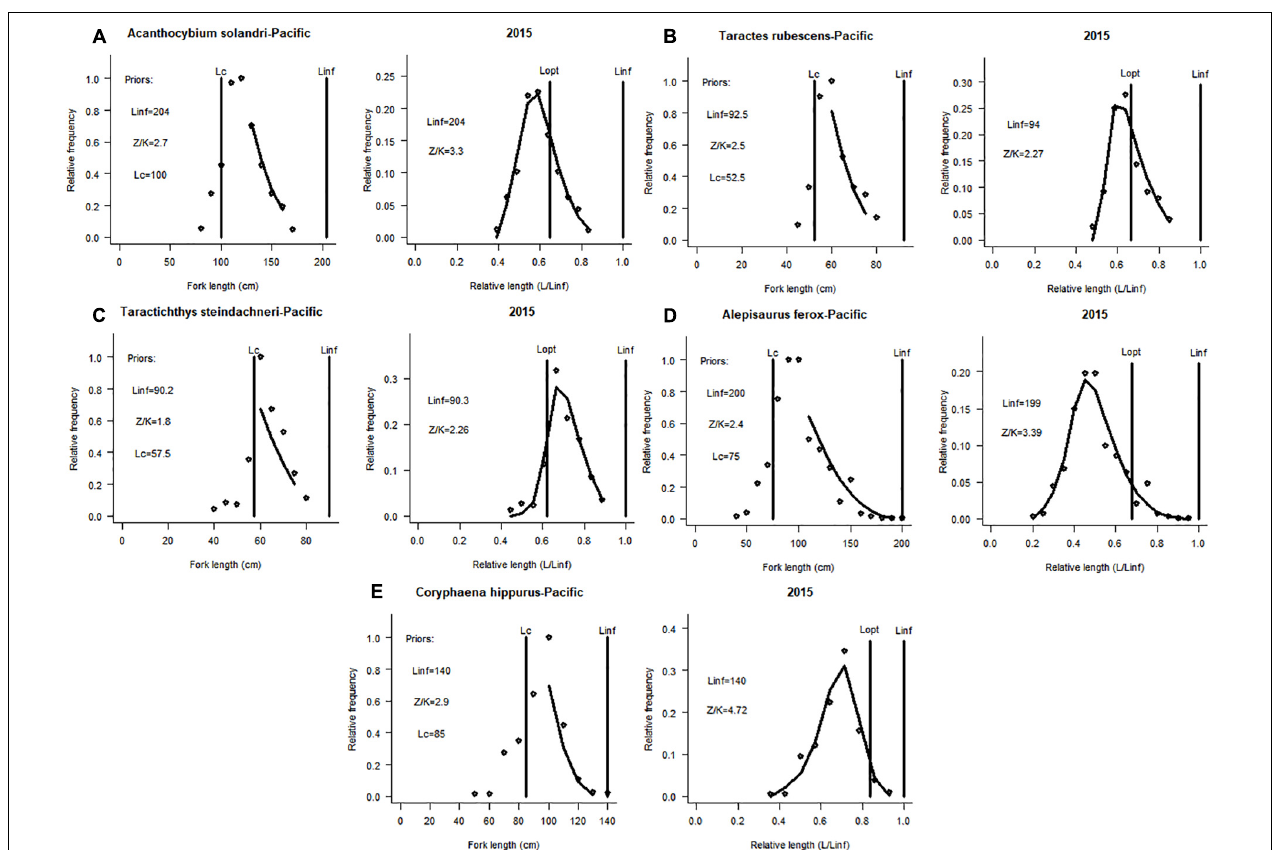
FIGURE 2 | Application of the LBB method to five non-target species (with available length-frequency data) caught by the Chinese tuna longline fisheries vessels operating in the Pacific Ocean (see also Table 1 and Supplementary Materials ). LBB plots for (A) Acanthocybium solandri (B) Taractes rubescens (C) Taractichthys steindachneri (D) Alepisaurus ferox (E) Coryphaena hippurus